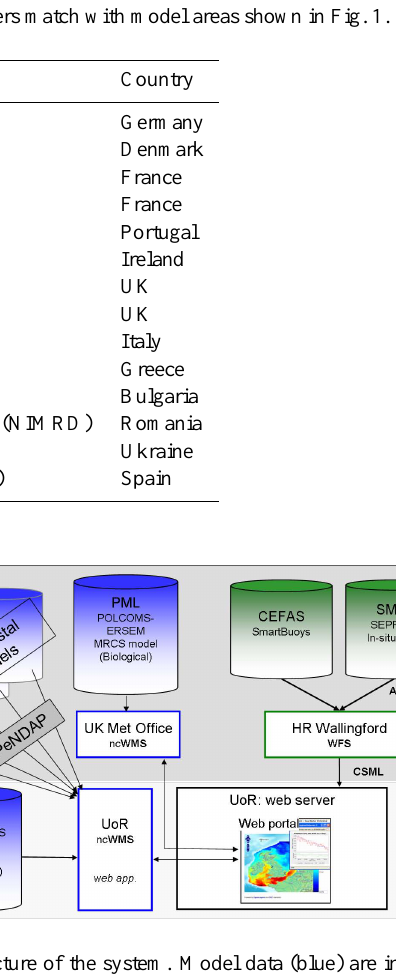
Fig. 1. The model regions available in the portal. Numbers repre- sent the institutes serving the model data as per Table 1.